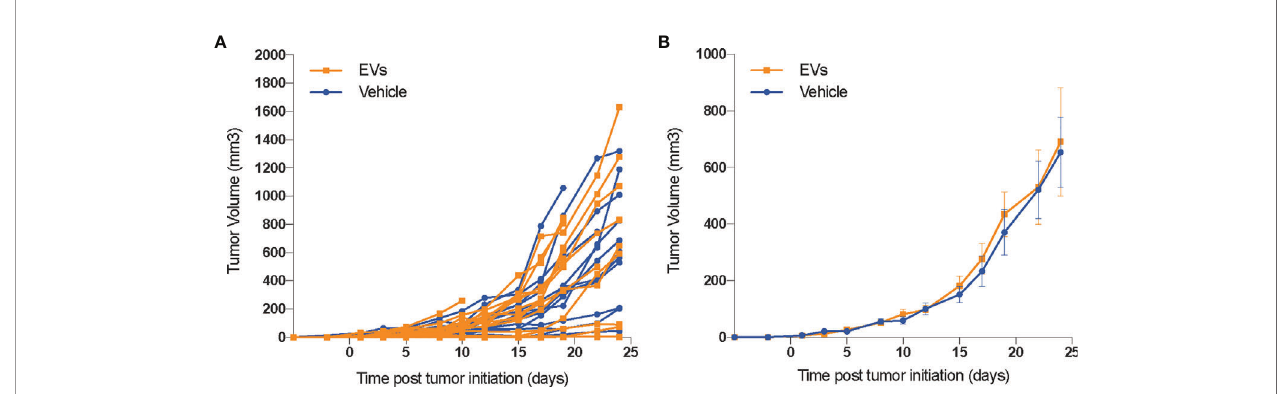
FIGURE 6 | EV do not promote the growth of xenograft tumors. In an initial safety screen, EV were not found to promote the growth of xenograft tumors. Mice injected (SQ) with 50,000 TC1 cells and treated with vehicle or hESC-derived EV the same day, were followed for tumor growth over 1 month. While some individual variation in tumor growth was observed (A) , averaged data (B) reveals no signi fi cant difference in tumor volumes between either cohort. Mean tumor volume ± SEM, n = 14 – 16 animals per